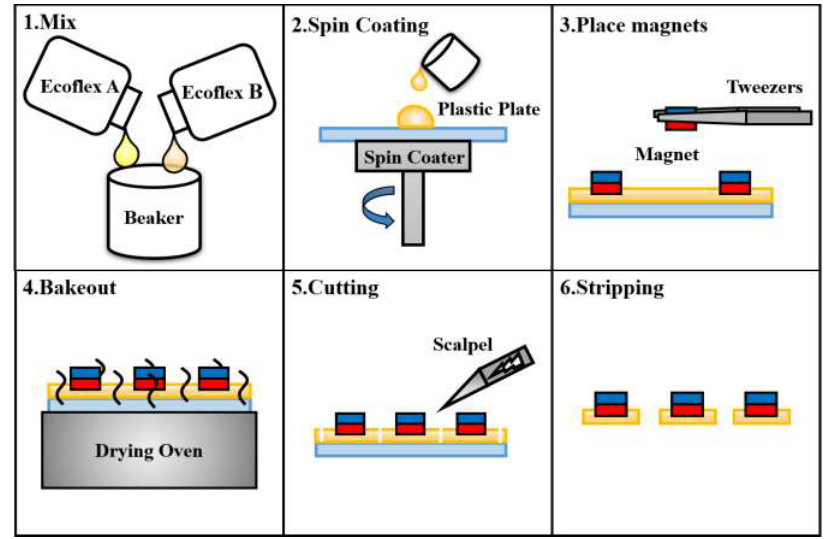
Figure 6. Fabrication process of the membrane for absorption/injection of the cell nucleus.